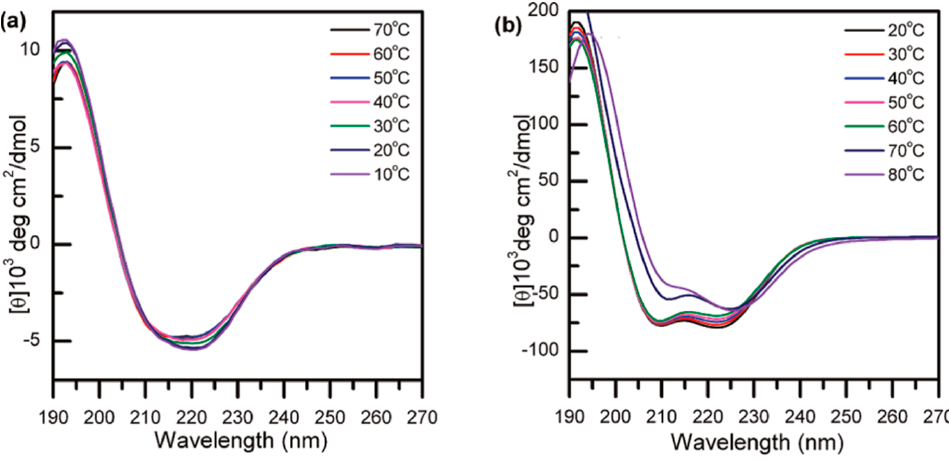
Figure 4. CD spectra of ( a ) poly- L -EG 2 Glu and ( b ) poly- L -EG 3 Glu as a function of temperature (heating scan). Reproduced with permission [34]. Copyright 2011, American Chemical Society.